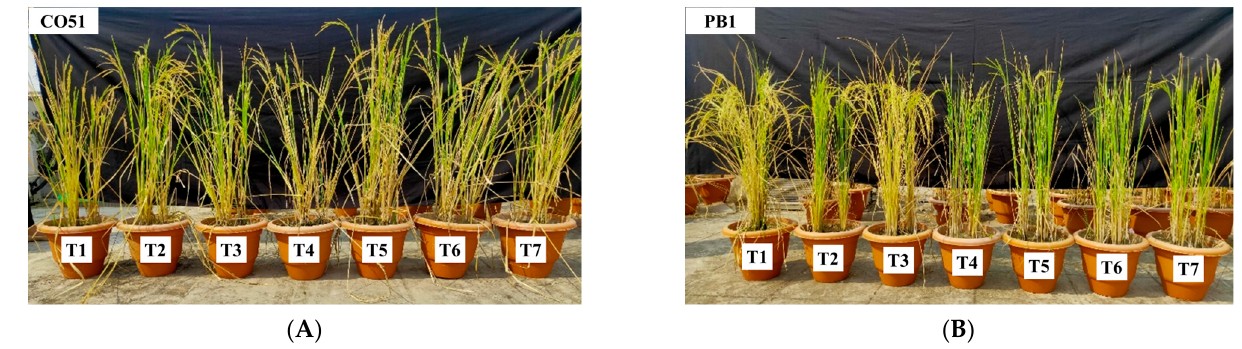
Figure 1. Effect of inoculation of halotolerant endophytes and rhizobacteria on two rice varieties ( A ) CO51, and ( B ) Pusa Basmati 1. Sequence of pots from left to right (in both of the figures): T1 = Negative control, T2 = Positive control (200 mM NaCl), T3 = 200 mM NaCl + Trichoderma viride , T4 = 200 mM NaCl + Bacillus haynesii 2P2, T5 = 200 mM NaCl + Bacillus safensis BTL5, T6 = 200 mM NaCl + Brevibacterium frigoritolerans W19, and T7 = 200 mM NaCl + Pseudomonas fluorescens.